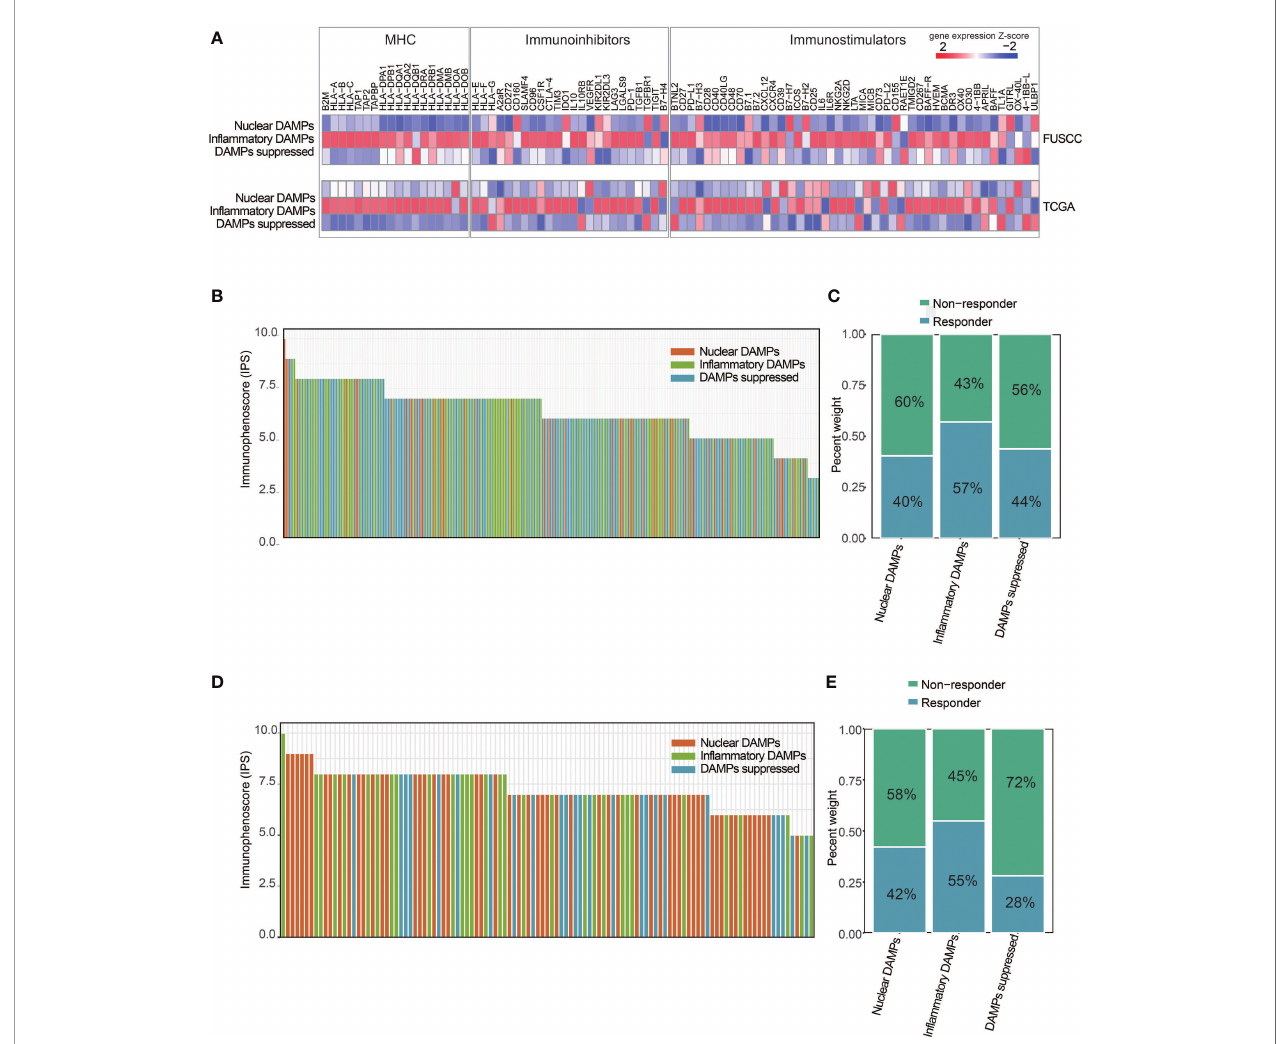
FIGURE 7 | DAMPs-associated clusters can predict immunotherapy outcome. (A) Expression of MHC and immunomodulatory molecules for DAMPs-associated subtypes. Expression values are represented by z scores calculated across all tumors and color coded according to the legend. (B) Waterfall plot illustrating the Immunophenoscores (IPS) according to the DAMPs-associated subtypes in the FUSCC cohort. (C) Proportion of patients: Responder and Nonresponder: 40%/60% in the nuclear DAMPs subtype, 57%/43% in the in fl ammatory DAMPs subtype and 44%/56% in the DAMPs-suppressed subtype. (D) Waterfall plot illustrating the IPS according to DAMPs-associated subtypes in the TCGA-TNBC cohort. (E) Proportion of patients: Responder and Non − responder: 42%/58% in the nuclear DAMPs subtype, 55%/45% in the in fl ammatory DAMPs subtype and 28%/72% in the DAMPs-suppressed